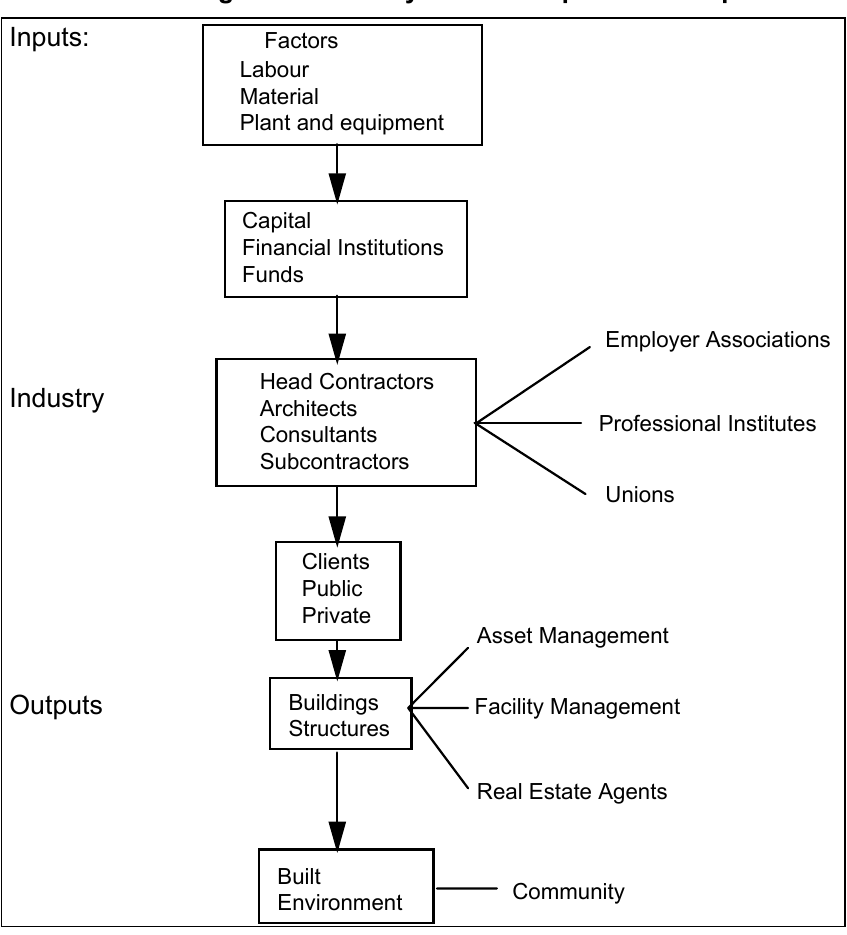
Figure 2. Industry Flows of Inputs and